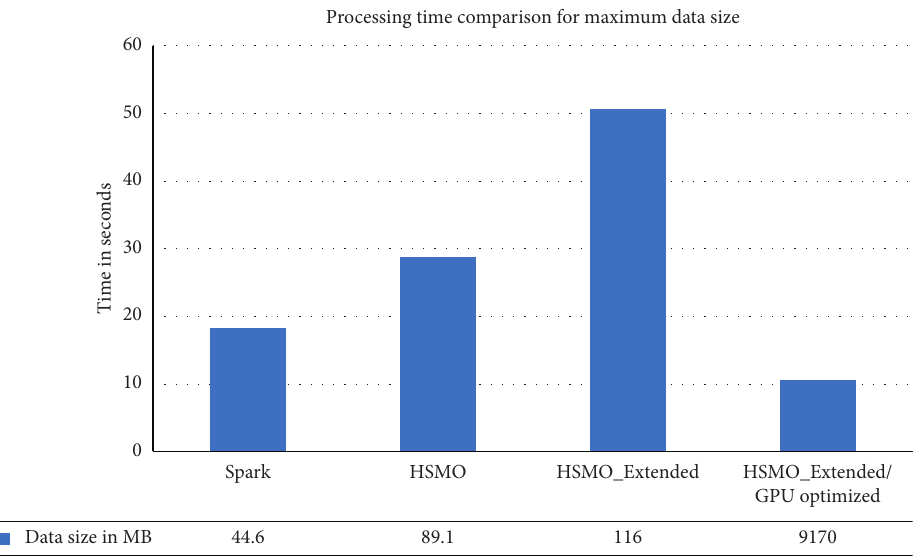
Figure 15: Processing time comparison for maximum data